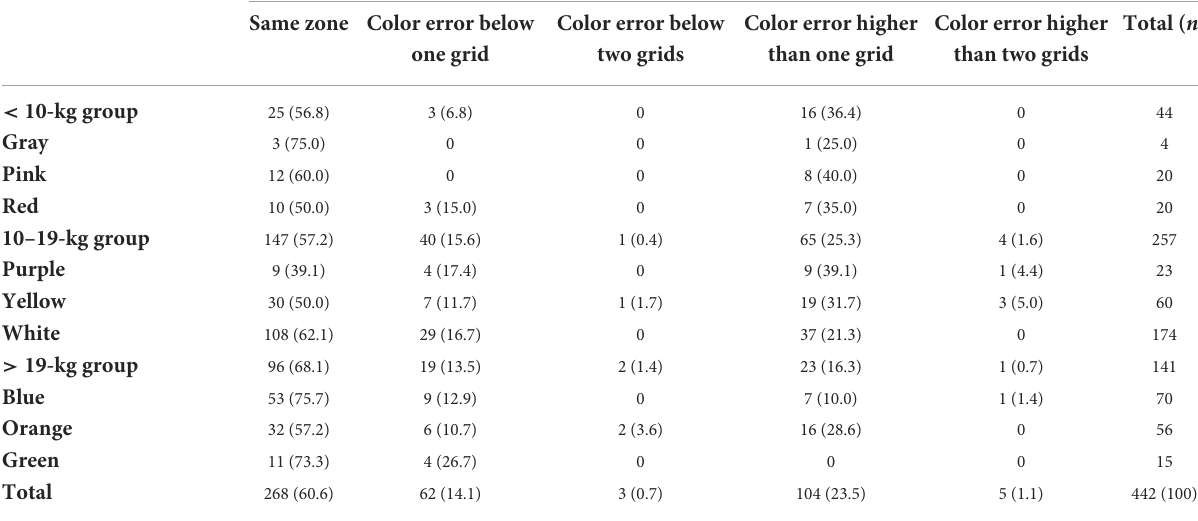
TABLE 2 Relationship between the estimated color zone of the Broselow tape and the color corresponding to the actual weight on the Broselow tape. Broselow tape color